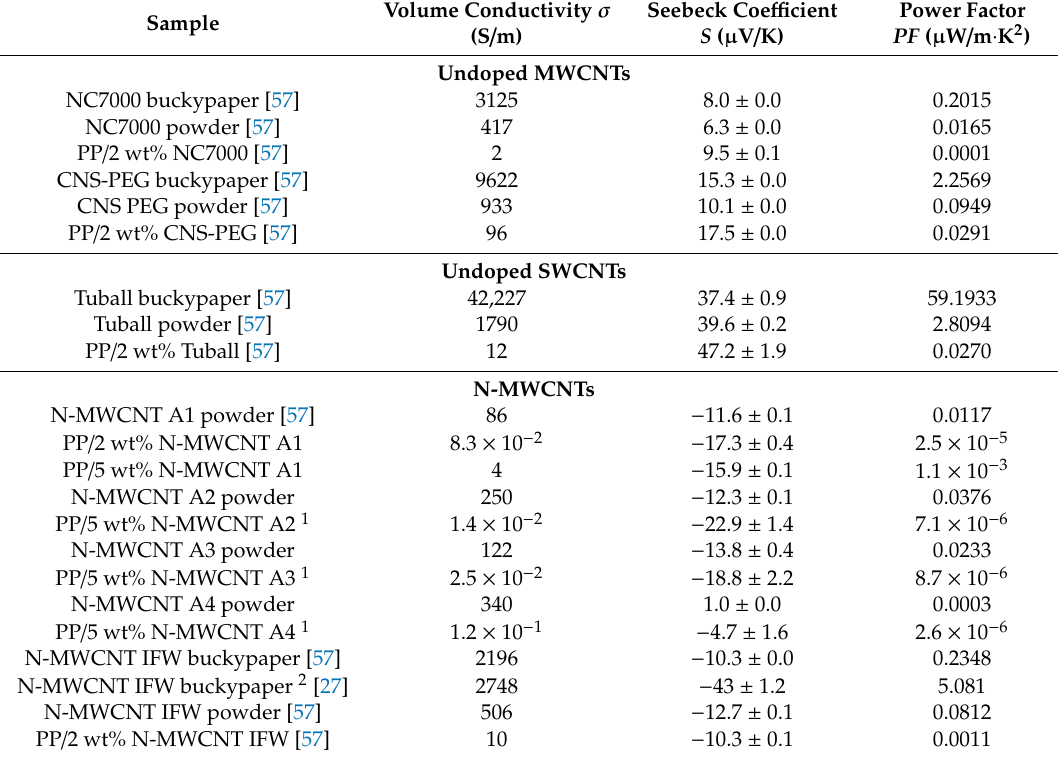
Table 2. Thermoelectric parameter of CNT buckypapers, powder packages and PP composites with 2 wt% or 5 wt%